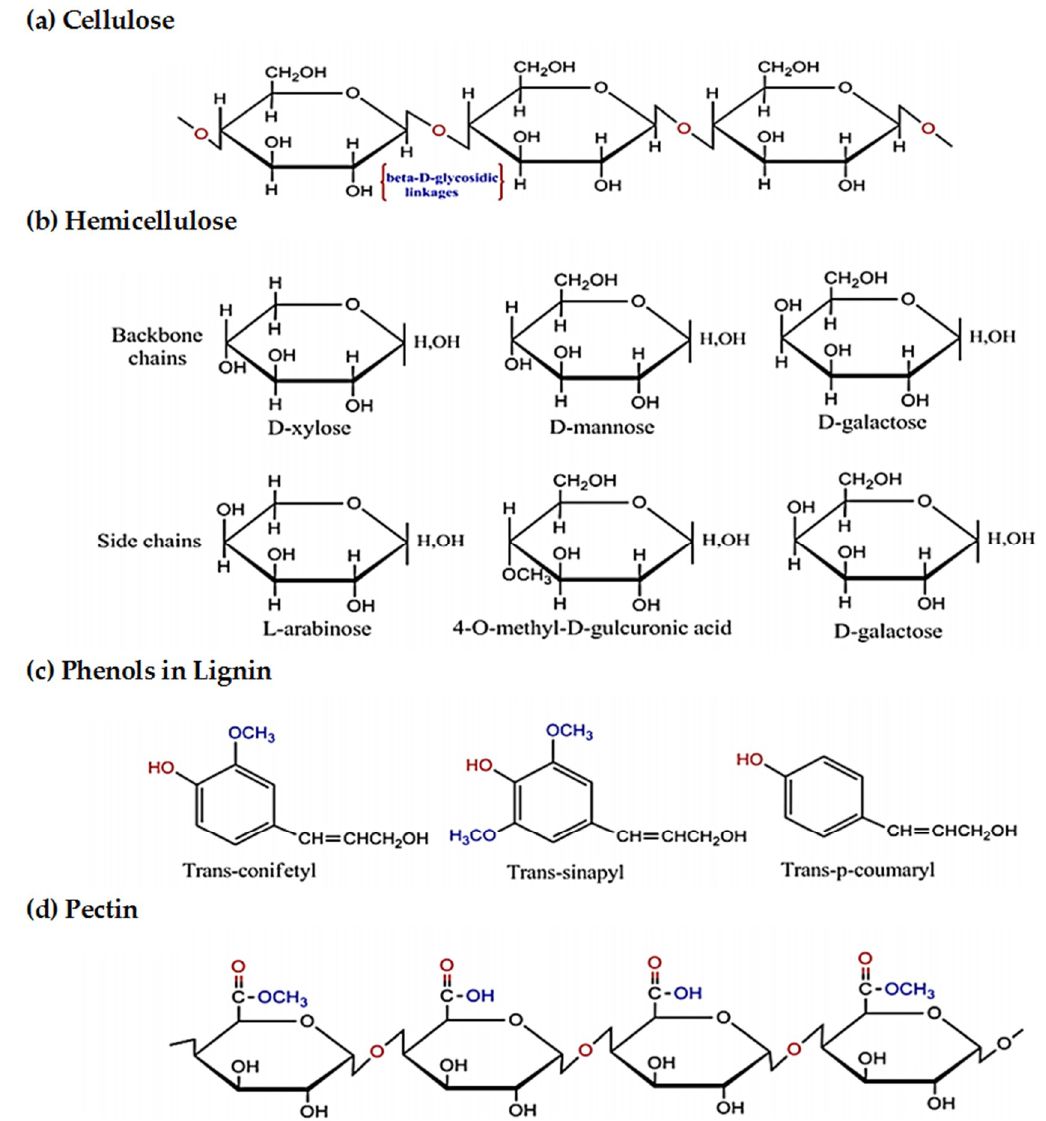
Figure 5. Chemical structure of the major constituents in the natural fibers: ( a ) cellulose; ( b ) hemicellulose; ( c ) lignin; ( d ) pectin. Adapted from [38] . ( b ) hemicellulose; ( c ) lignin; ( d ) pectin. Adapted from